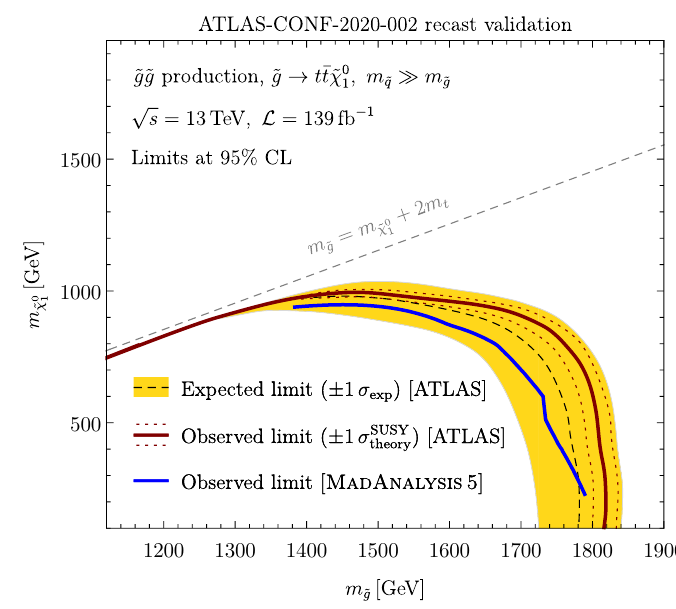
Figure 4 . Exclusion limits on gluino pair production in the ( m ˜ g , m ) plane, assuming gluino ˜ χ 0 1 decays to t ¯ t + ˜ χ 0 via a virtual squark ˜ q . Red and black/yellow results were obtained from figure 1 10(b) of ATLAS-CONF-2020-002 [1]. The blue exclusion curve is imposed on the benchmark model described in the text by our reimplementation of this analysis, and constitutes our validation of this reimplementation. Our limits are weaker than those of the official analysis, but this is to be expected — see text. At any rate, discrepancies are of O (10)%